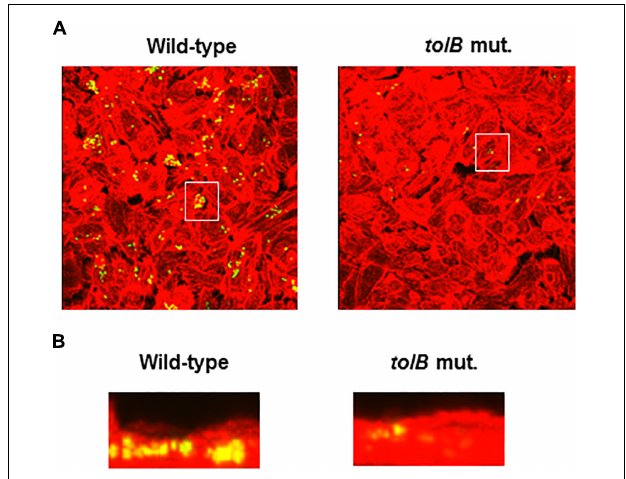
FIGURE 3 | Fluorescent images of aggregated UPEC cells within bladder epithelial cells (HTB-9). Bacteria carrying a Green fluorescence protein (GFP) expression plasmid, pTurboGFP-B and HTB-9 stained with rhodamine- phalloidin were imaged as, respectively, green and red fluorescent colors on the microscopy using 60 × objective. Overlooking images (A) and cross sectional images in the white box indicated in panel A (B) were acquired for each sample. The experiment was repeated twice and similar results were